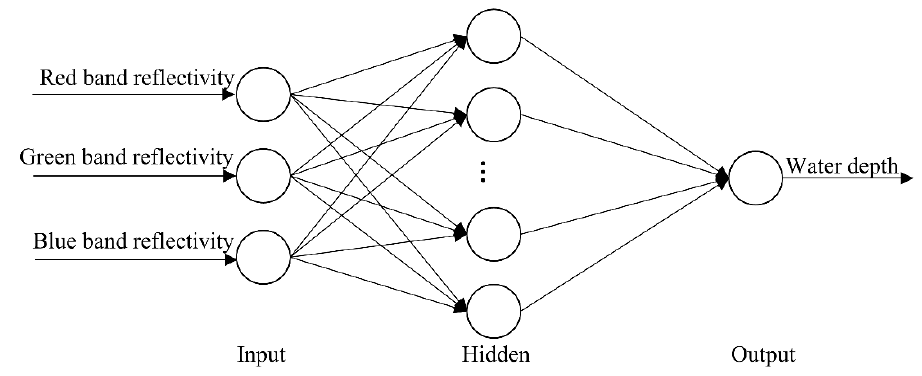
Figure 6. Satellite-derived bathymetry structure based on BP neural network model.